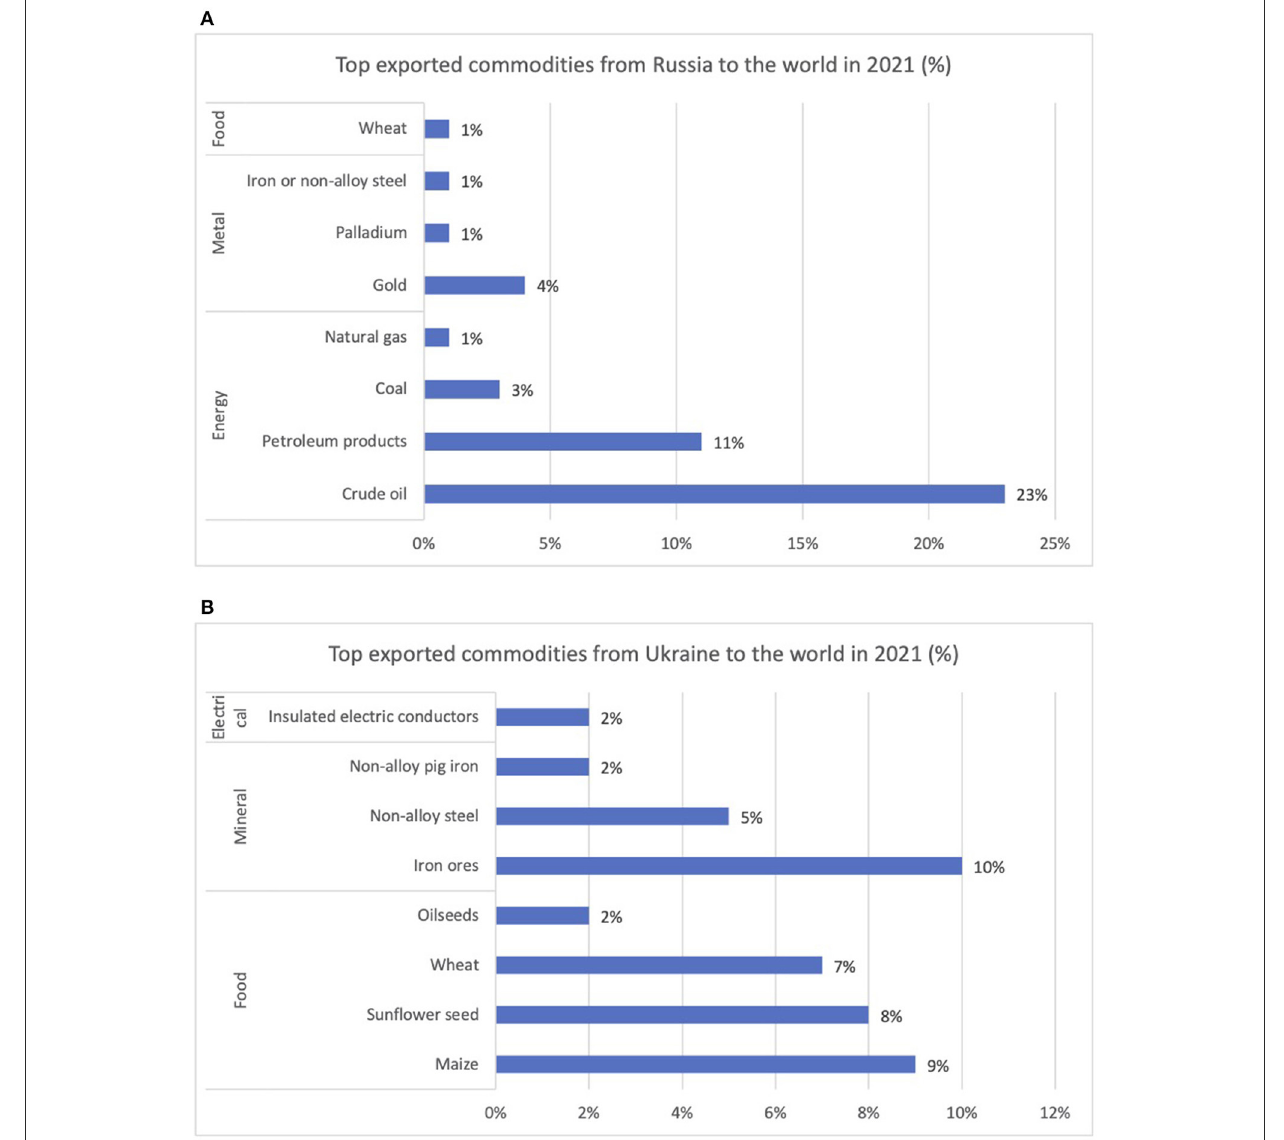
FIGURE2 Top exported commodities in (A) Russia, and (B) Ukraine in 2021 (UN Comtrade Database Intelligence, 2021).